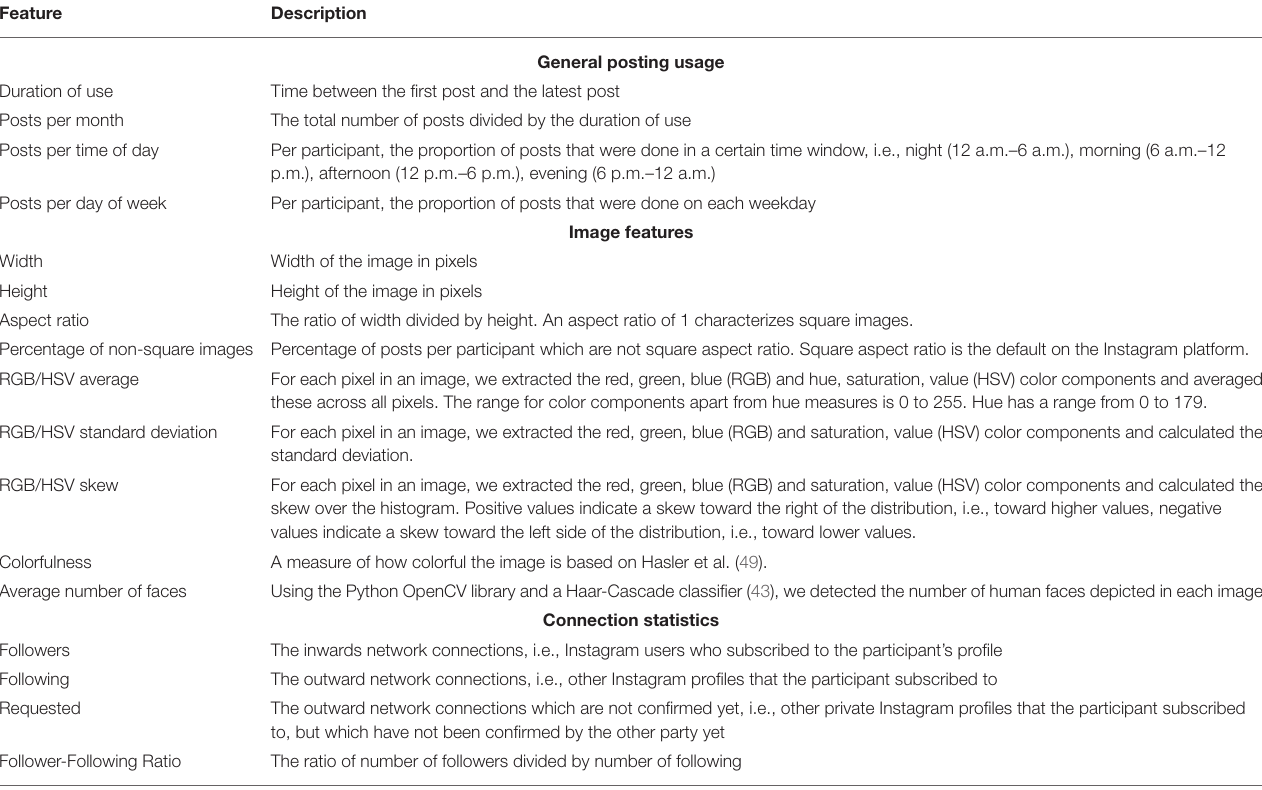
TABLE 1 | Overview of generated